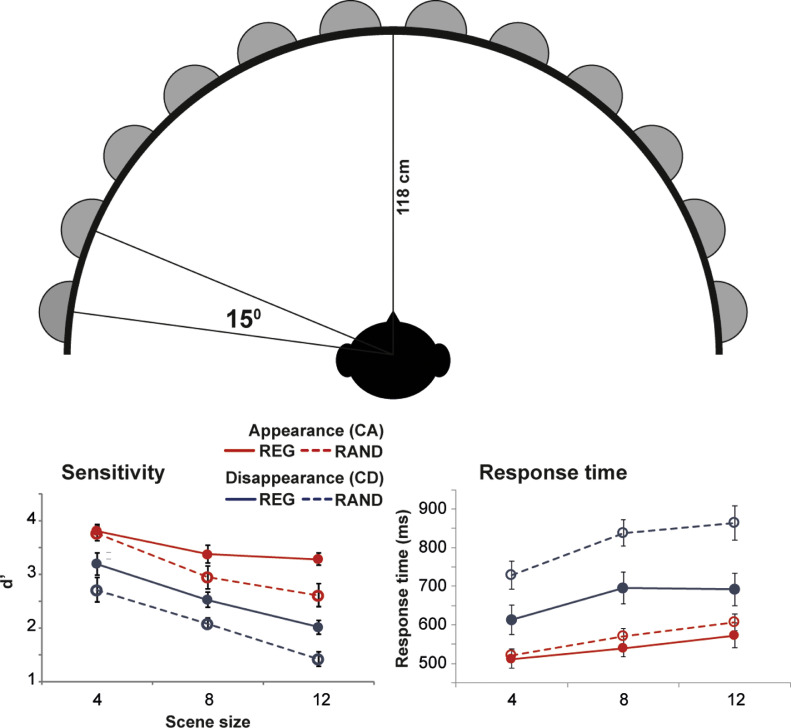
Experiment 1B. [top] Schematic diagram of the loudspeaker array. [bottom] Results of Experiment 1b. Error bars are 1 standard error (SE). In all measures (d’ and response time) performance is significantly reduced in RAND relative to REG scenes.